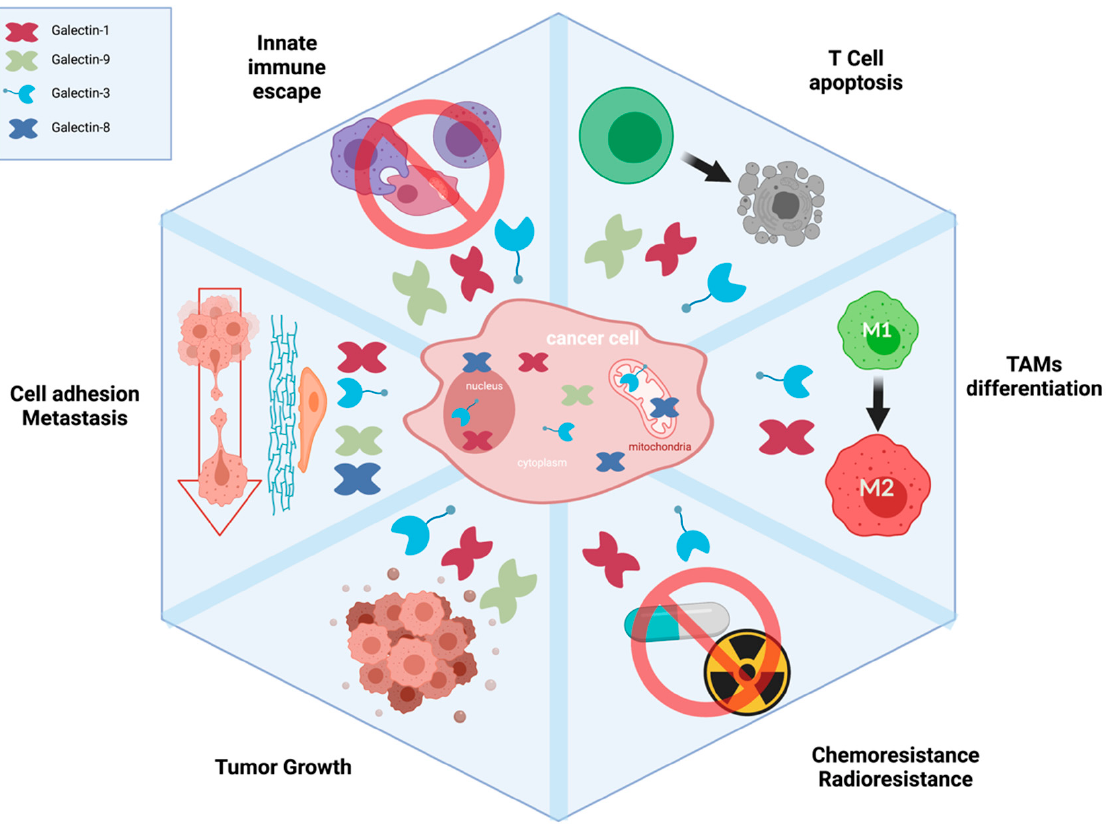
Figure 2. Impact of galectins on the hallmarks of